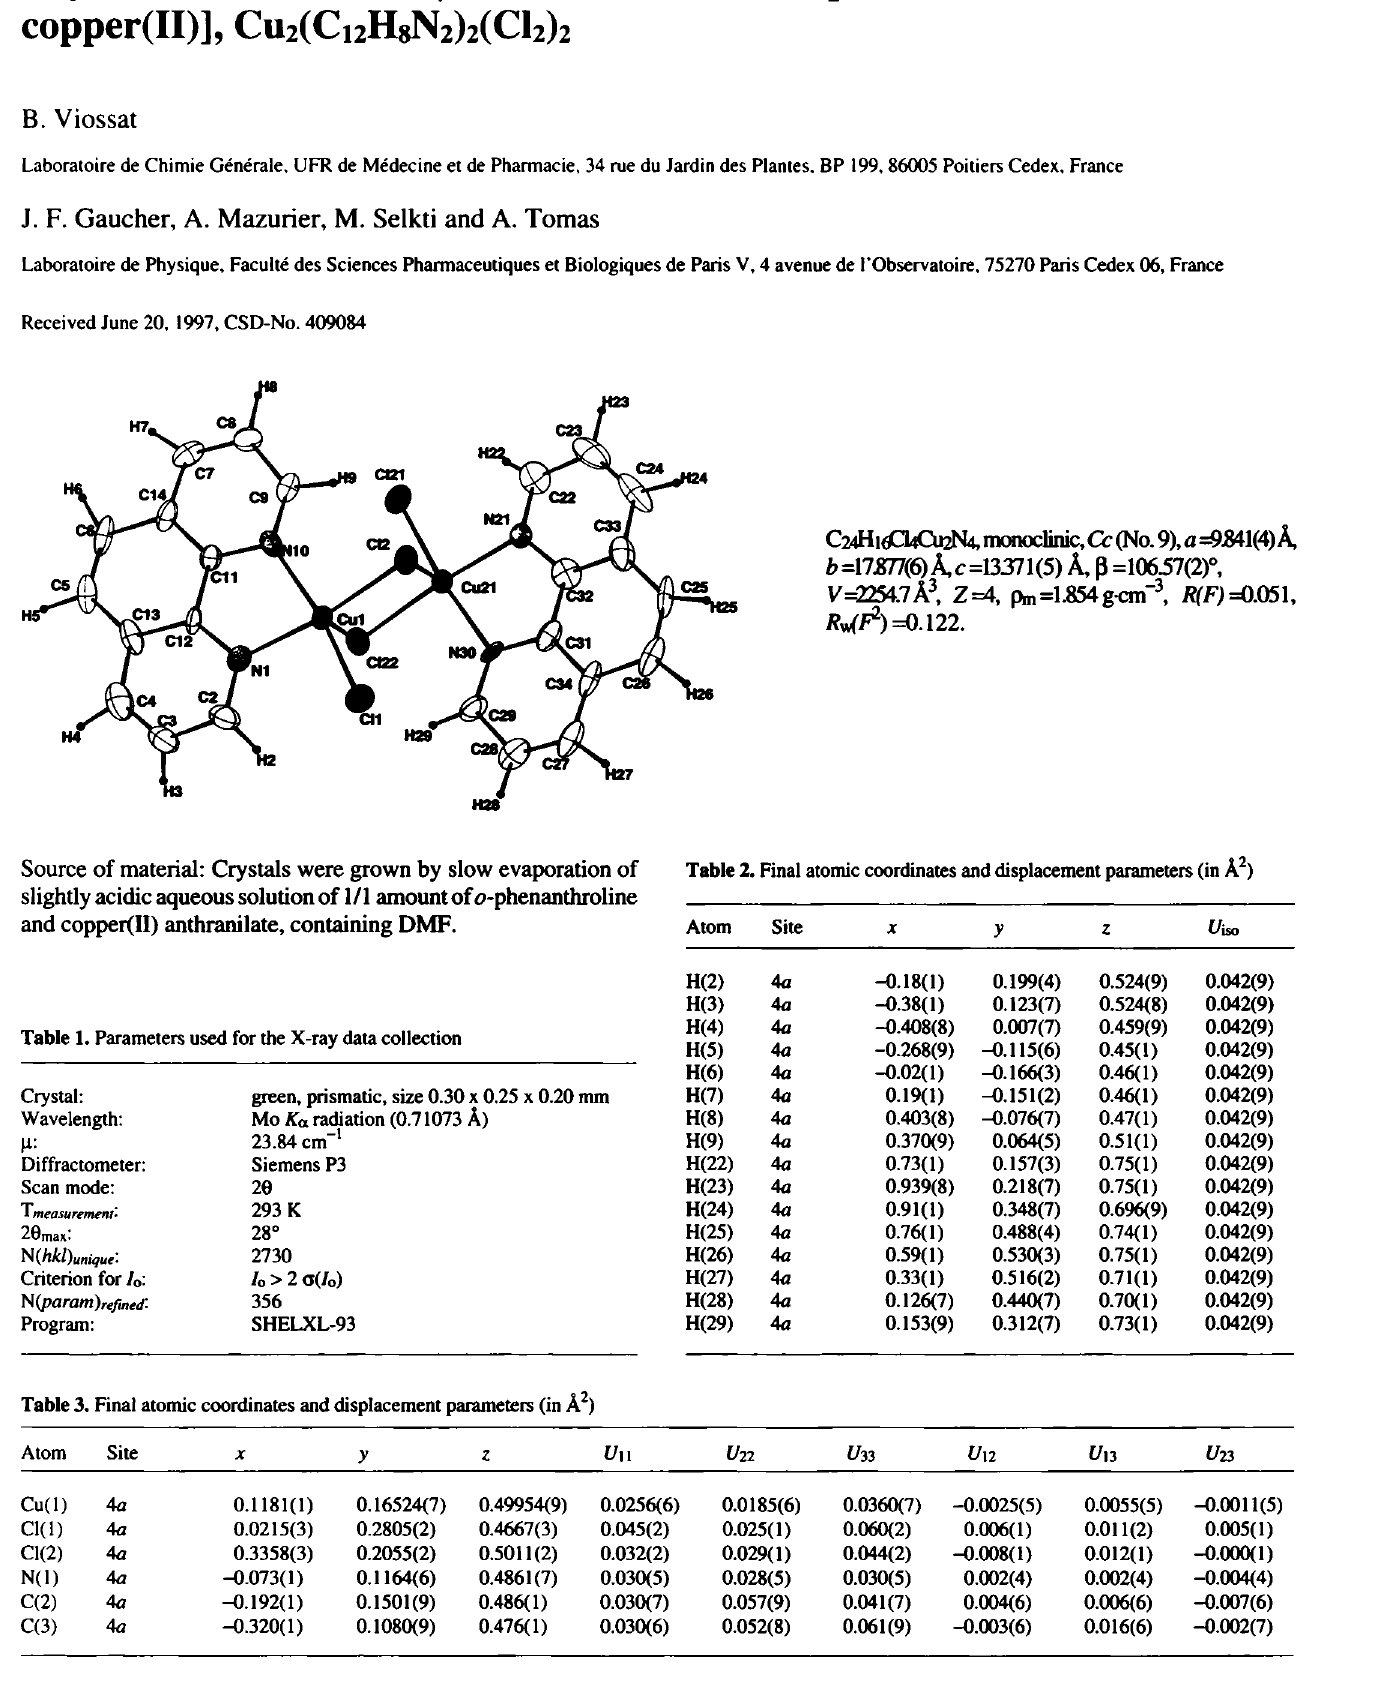
Table 1. Parameters used for the X-ray data collection